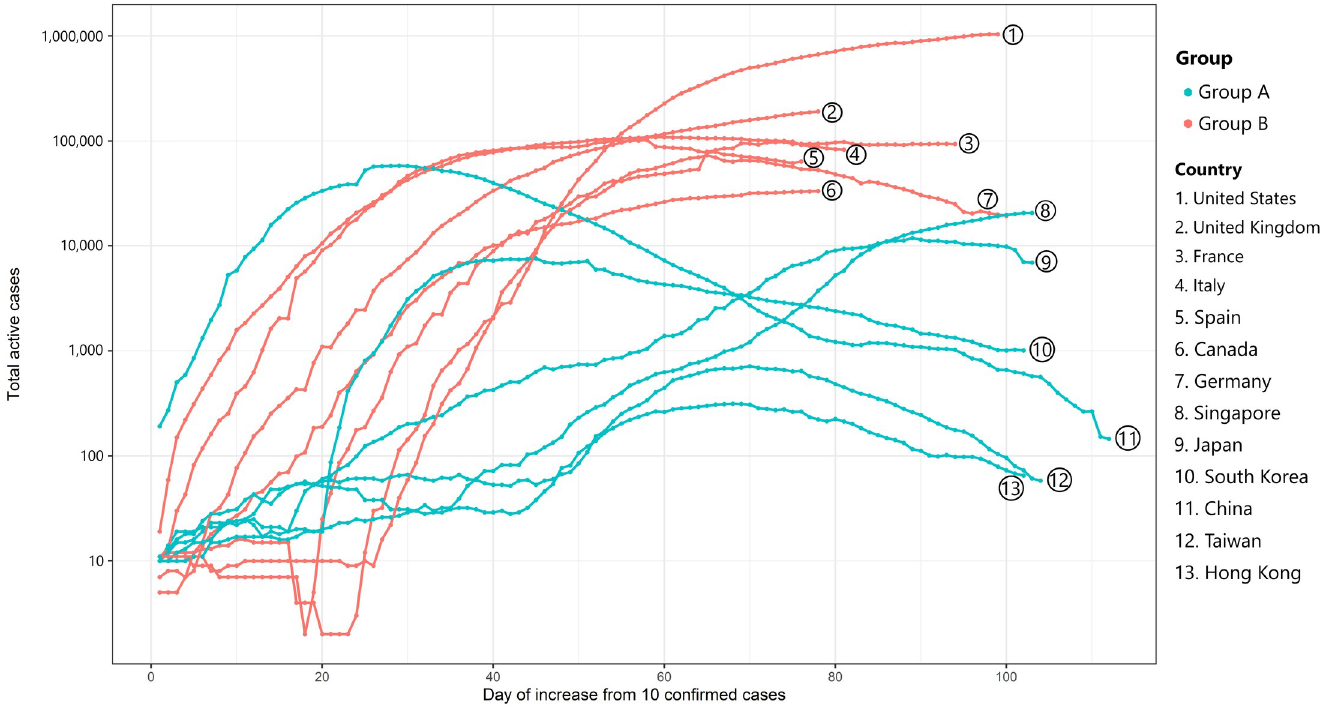
Fig 2. The comparison of countries’ active cases since the 10th confirmed case of